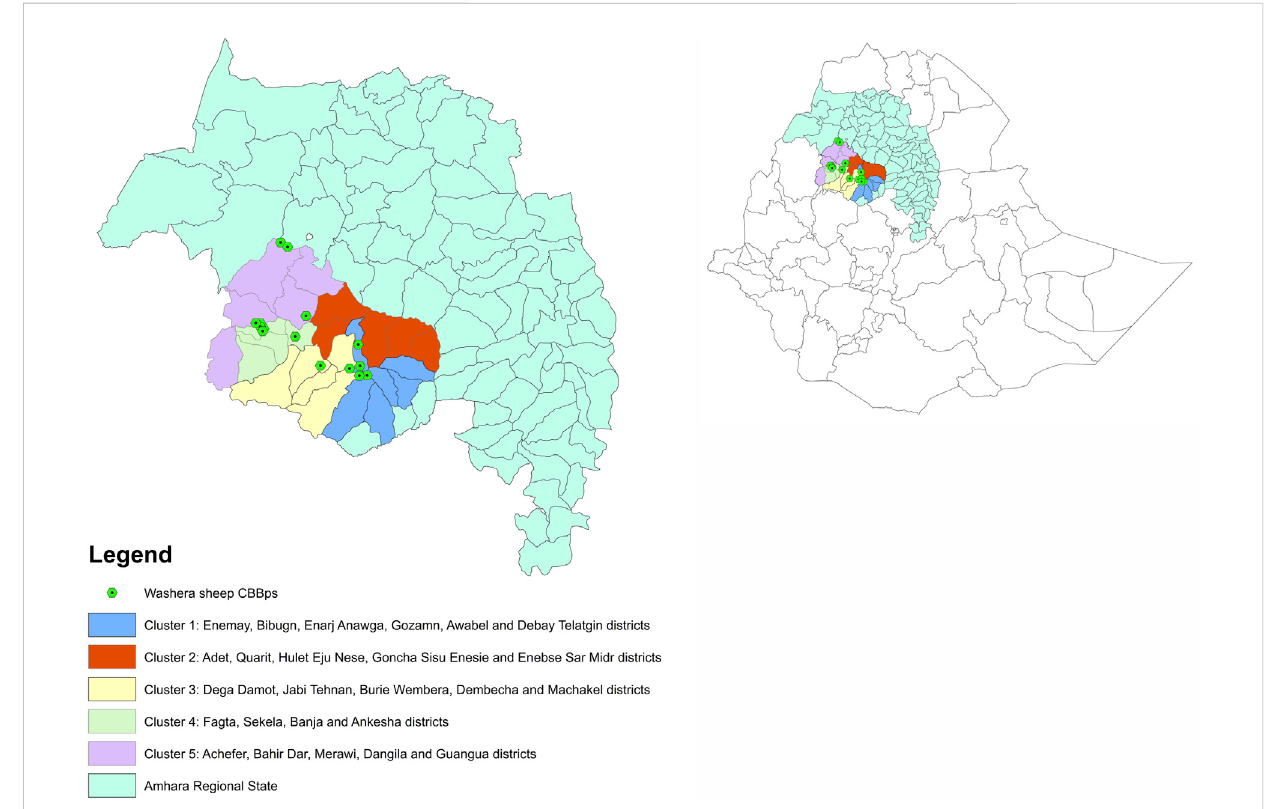
FIGURE 1 Position of Amhara Regional State in Ethiopia, Washera sheep breed distribution and clusters and location of the current 28